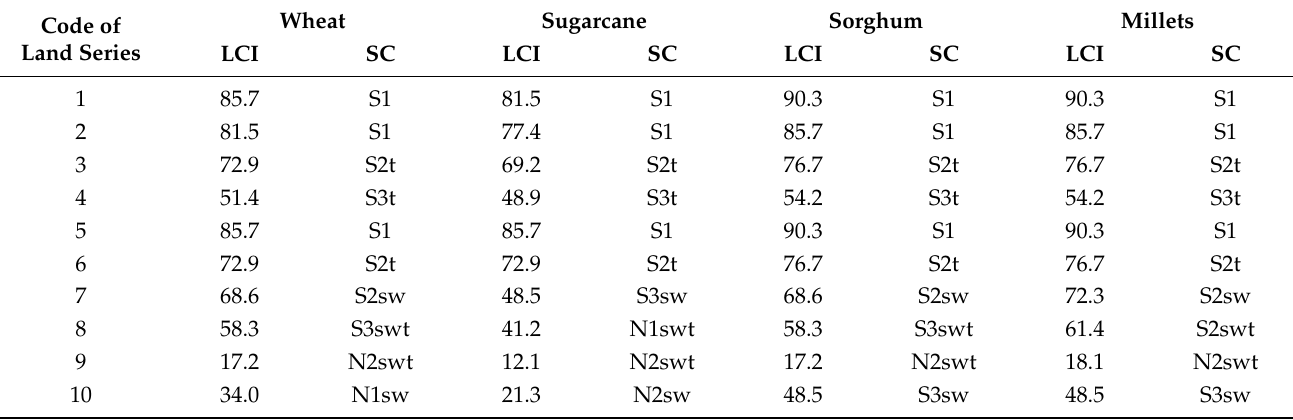
Table 4. The Ci values and suitability classes of surface irrigation for each land series using the parametric land suitability analysis method